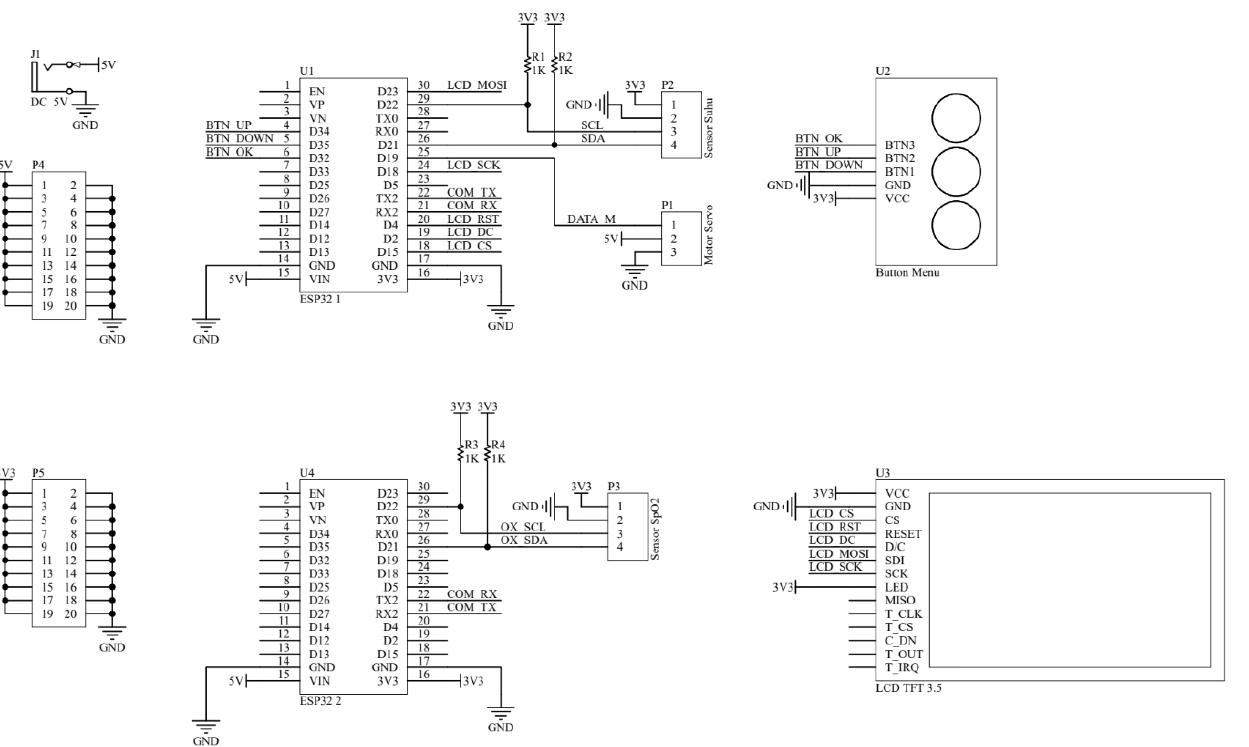
Figure 2. Schematic design.